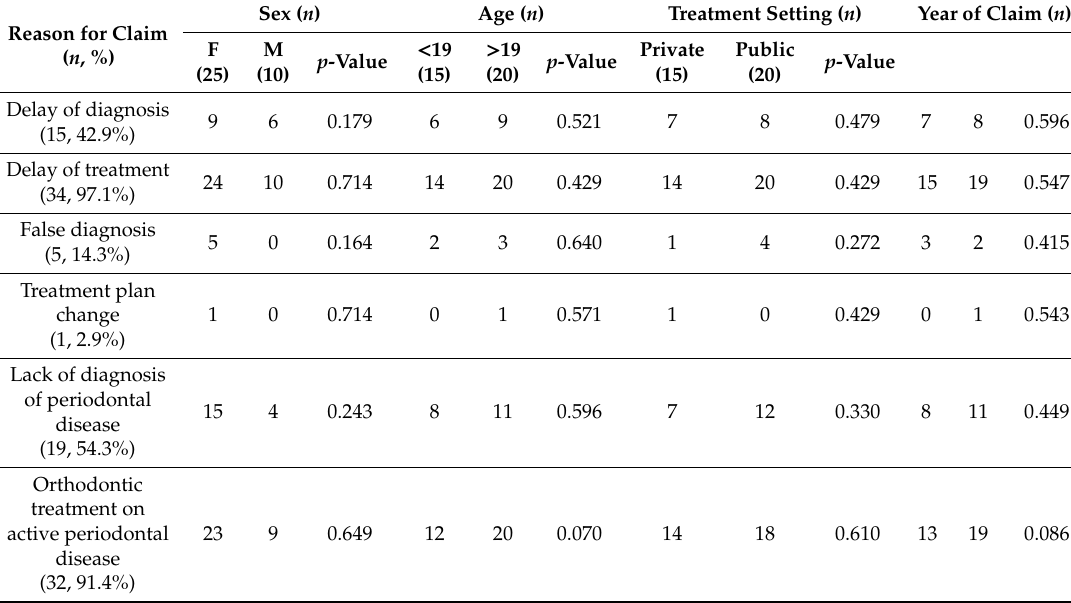
Table 3. Reasons of claim divided by gender, age, and treatment